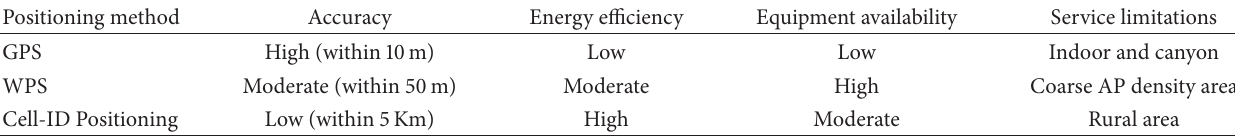
Table 1: Characterization of various positioning